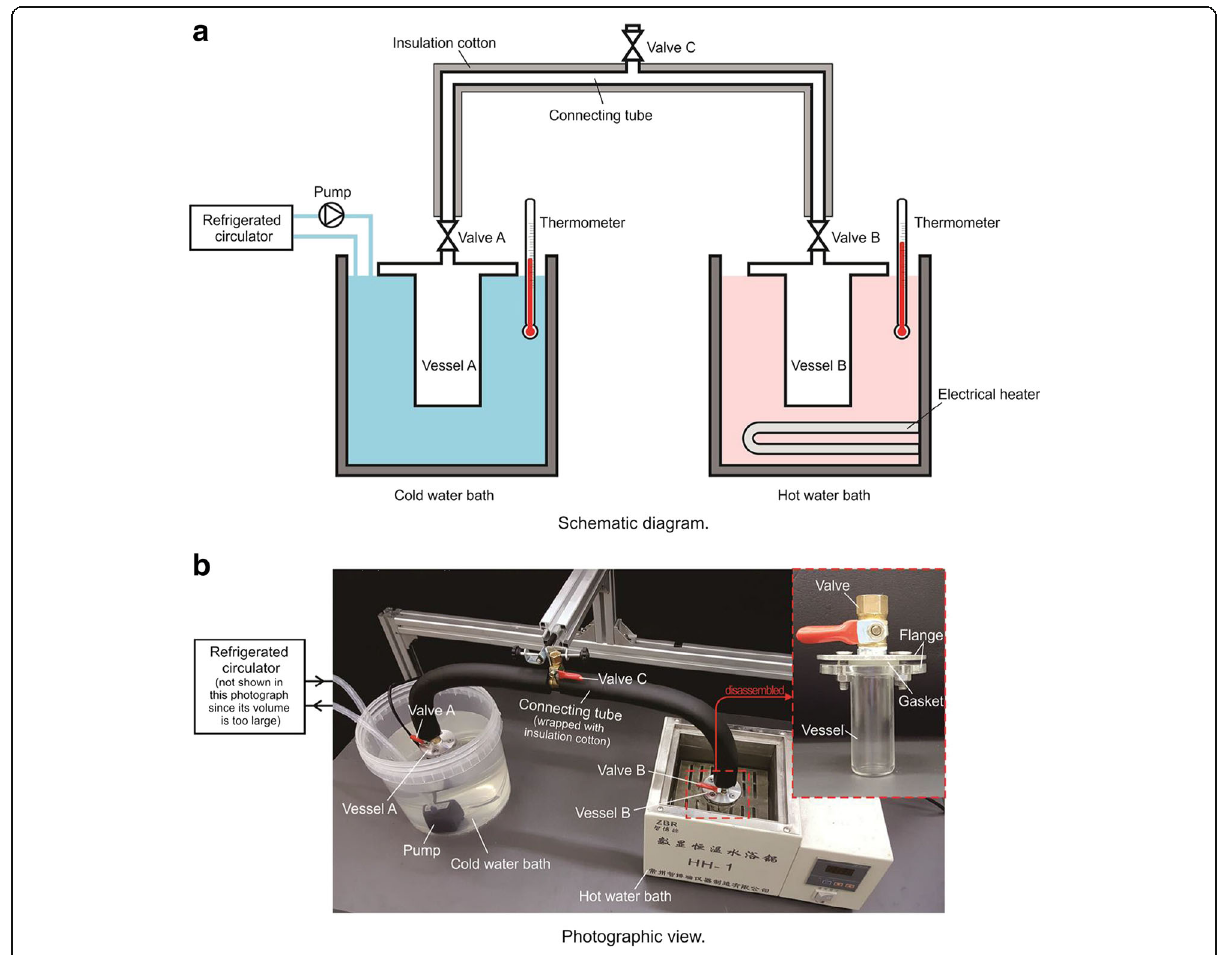
Fig. 8 a , b Experimental setup for condensation – evaporation alternation [15]. Reproduced with permission from Elsevier